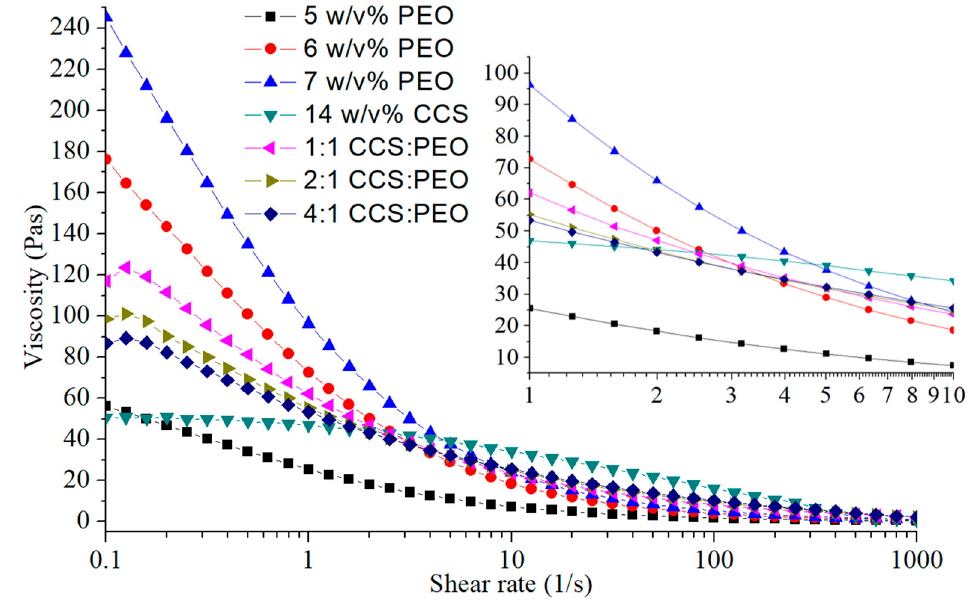
Figure 3. The viscosities of various polymer solutions.